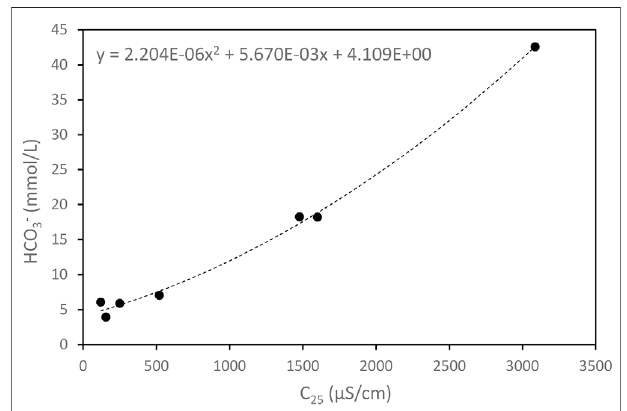
FIGURE7| CorrelationbetweentheHCO 3 ‾ concentrationandelectrical conductivity. The correlation was approximated by the quadratic equation as shown in the fi